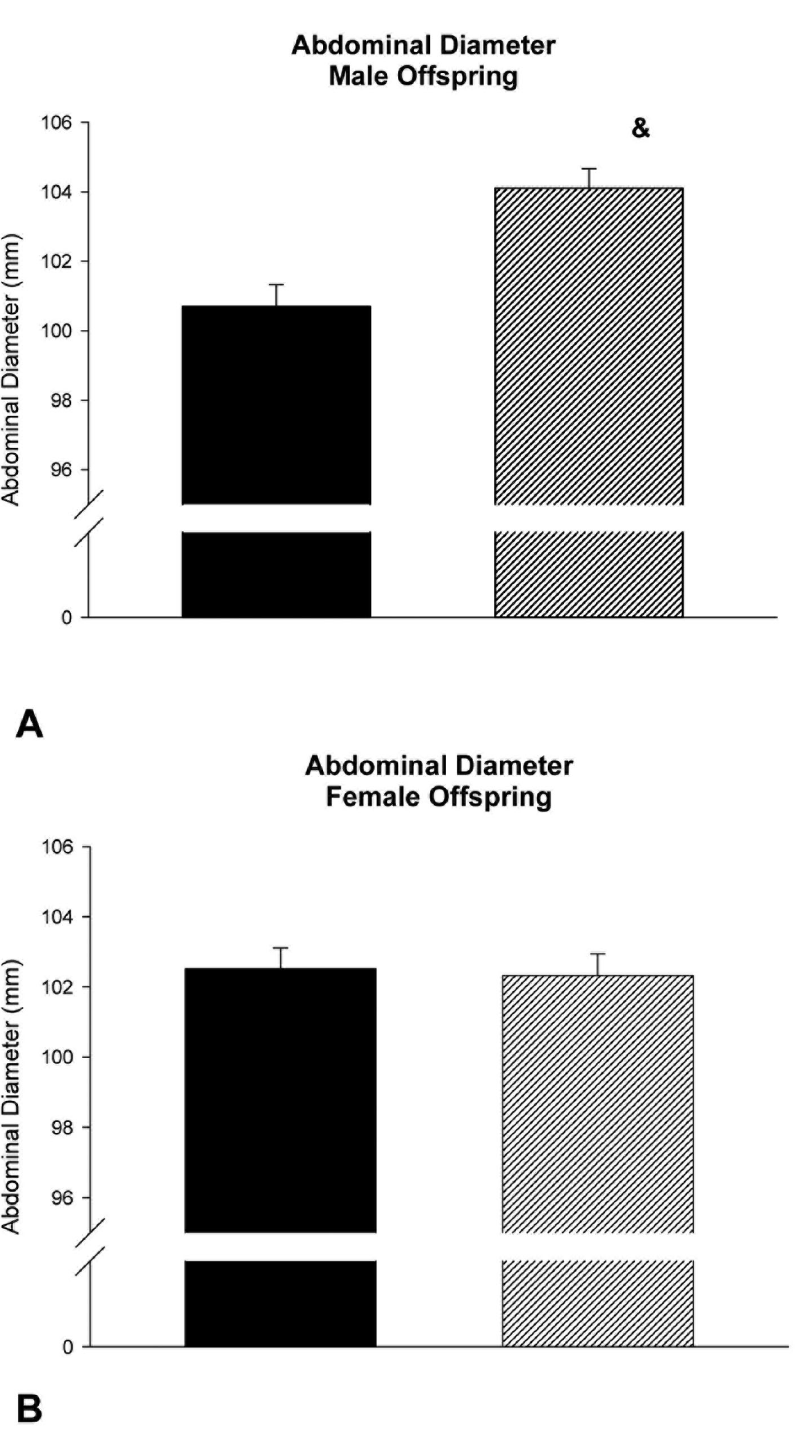
Figure 2. Abdominal diameter of male (A) and female (B) offspring in relationship to paternal BMI. Ultrasound examination was done in average at gestational day 266.8. Black Bar: Paternal BMI below median; Hatched Bar: Paternal BMI above median. &: p=0.003 versus male offspring of fathers with a BMI below the median of all paternal BMI data.